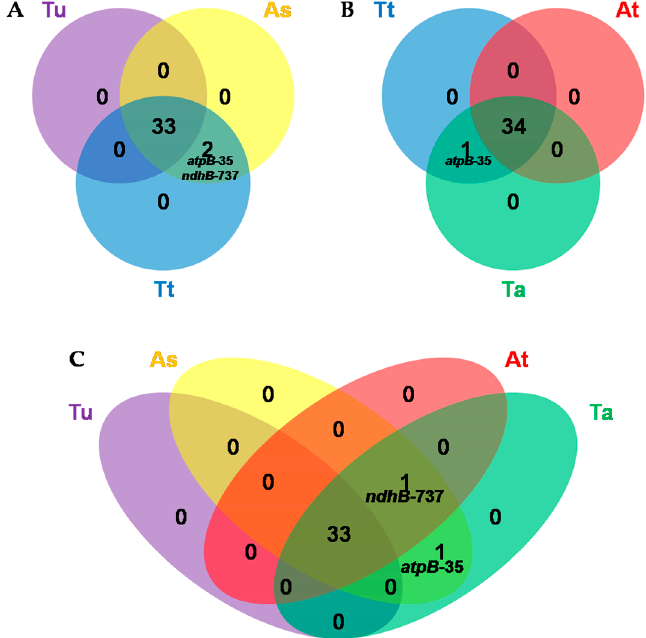
Figure 4. Comparison of RNA editing sites in chloroplast genes of T. aestivum and its genome donors. ( A ) Comparison among T. urartu , Ae. speltoides and T. turgidum ; ( B ) Comparison among T. turgidum , Ae. tauschii and T. aestivum ; ( C ) Comparison among T. urartu , Ae. speltoides , Ae. tauschii and T. aestivum . Tu indicates T. urartu (PI428335); As indicates Ae. speltoides (AE918, TA1796 and PI487232); At indicates Ae. tauschii (AL8/78); Tt indicates T. turgidum ssp. dicoccoides (TA0073, TA0060 and TA1133); and Ta indicates T. aestivum cv CS (TA3008). T. urartu , Triticum urartu L. Ae. speltoides , Aegilops speltoides L. T. turgidum, Triticum turgidum L. Ae. tauschii , Aegilops tauschii L. T. aestivum , Triticum aestivum L.